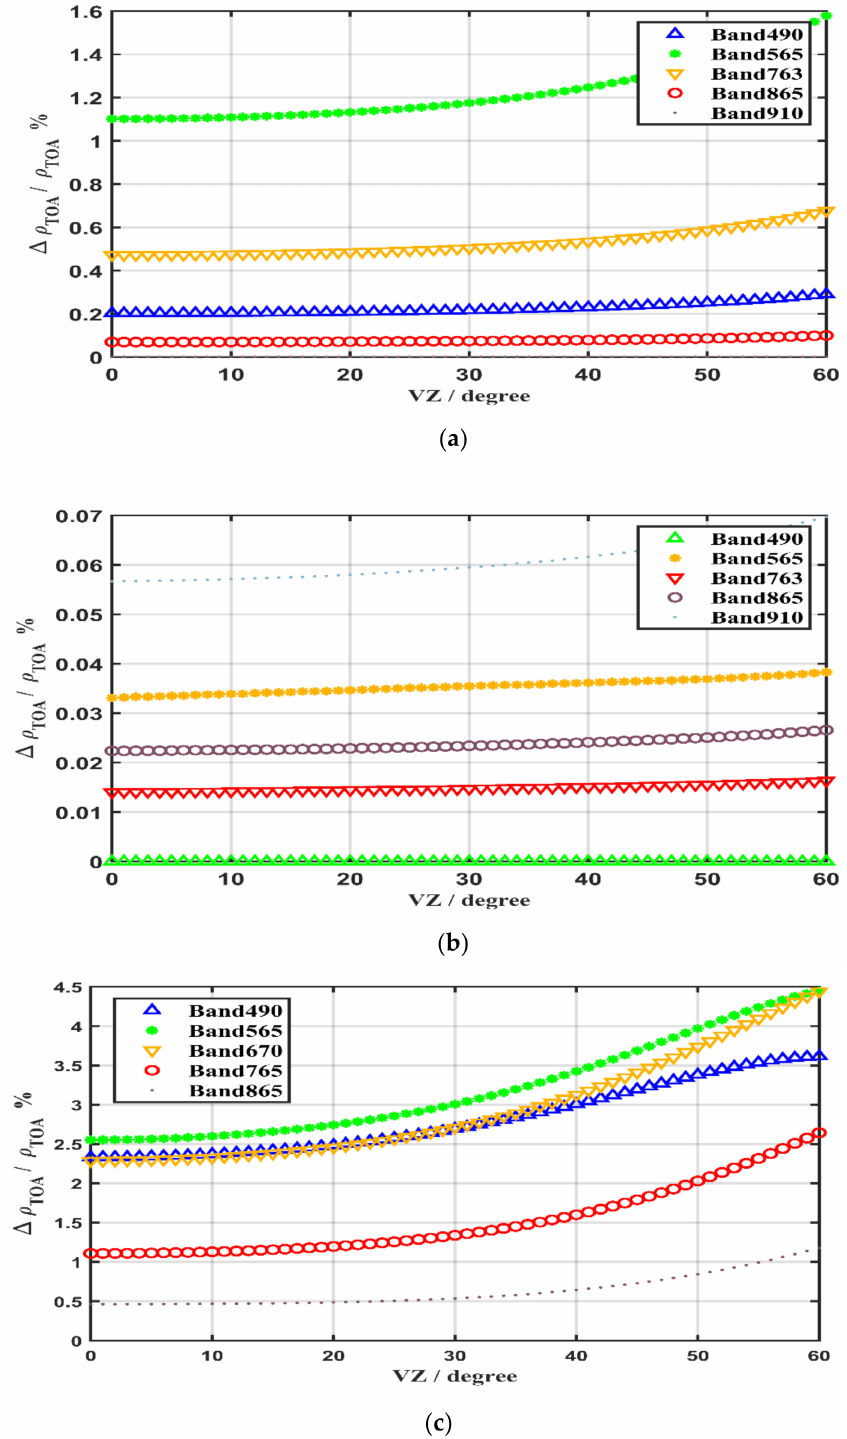
Figure 8. The TOA reflectance error varies with view zenith angle caused by uncertainty of the input parameter over an LNES. ( a ) The error caused by total amount of ozone uncertainty. ( b ) The error caused by total amount of water uncertainty. ( c ) The error caused by aot550